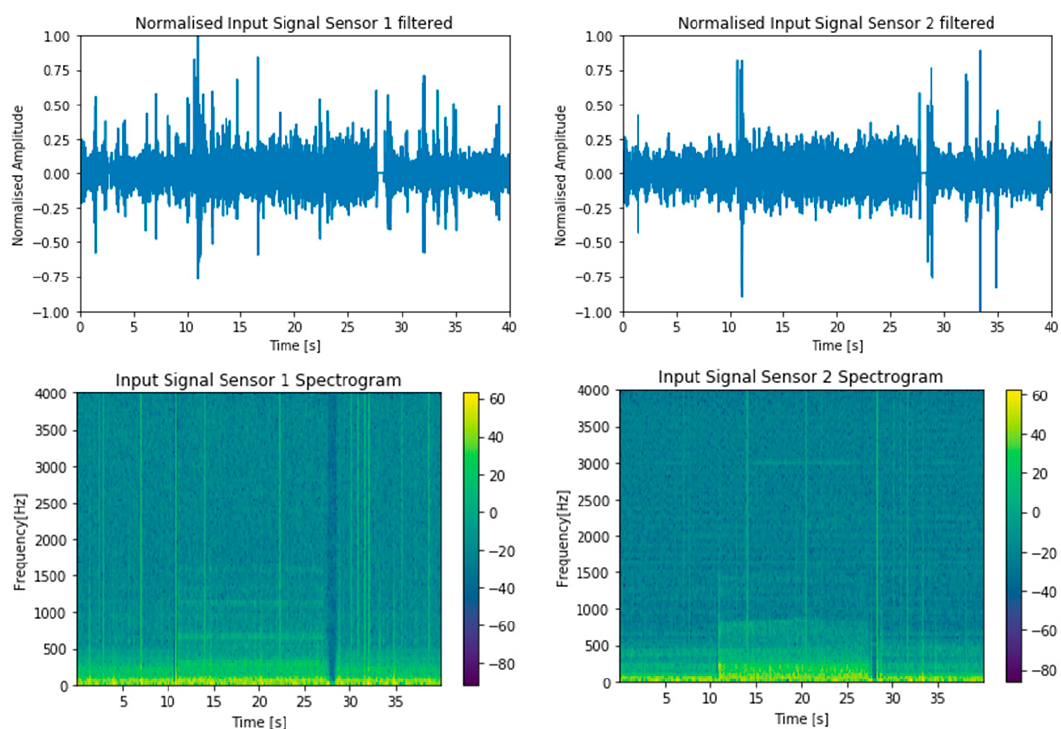
Figure 10. Frequency Analysis of filtered signals.